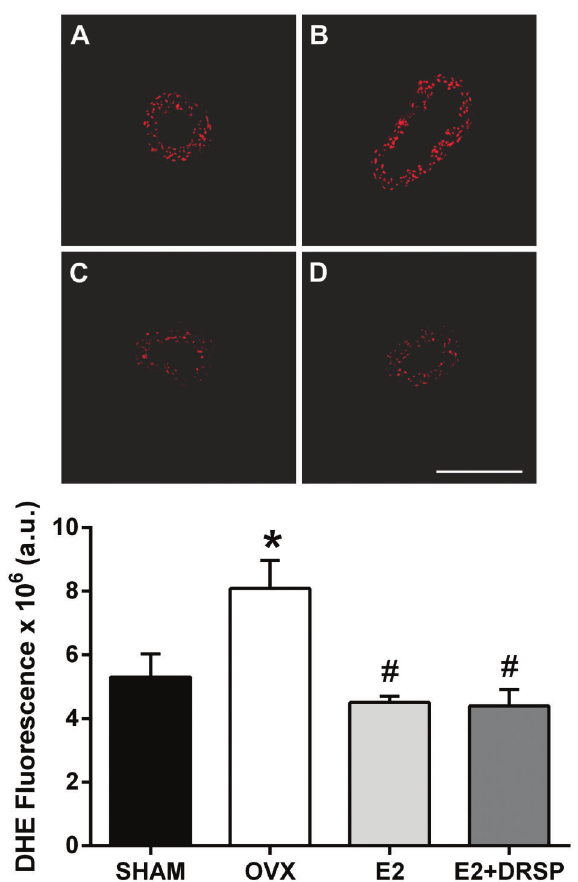
Figure 4. Analysis of oxidative stress in coronary arteries from ovariectomized spontaneously hypertensive rats by dihydroethid- ium fl uorescence (DHE). Data are reported as means ± SE (n=4 per group). Representative images of Sham ( A ), OVX ( B ), E2 ( C ) and E2 + DRSP ( D ) groups are shown. OVX: ovariectomized; E2: estrogen; DRSP: drospirenone. *P o 0.05 compared to